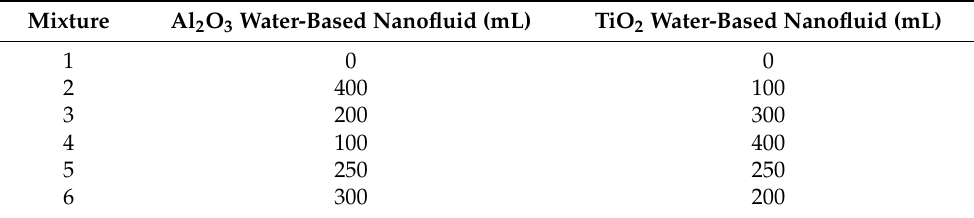
Table 1. Hybrid nanofluid